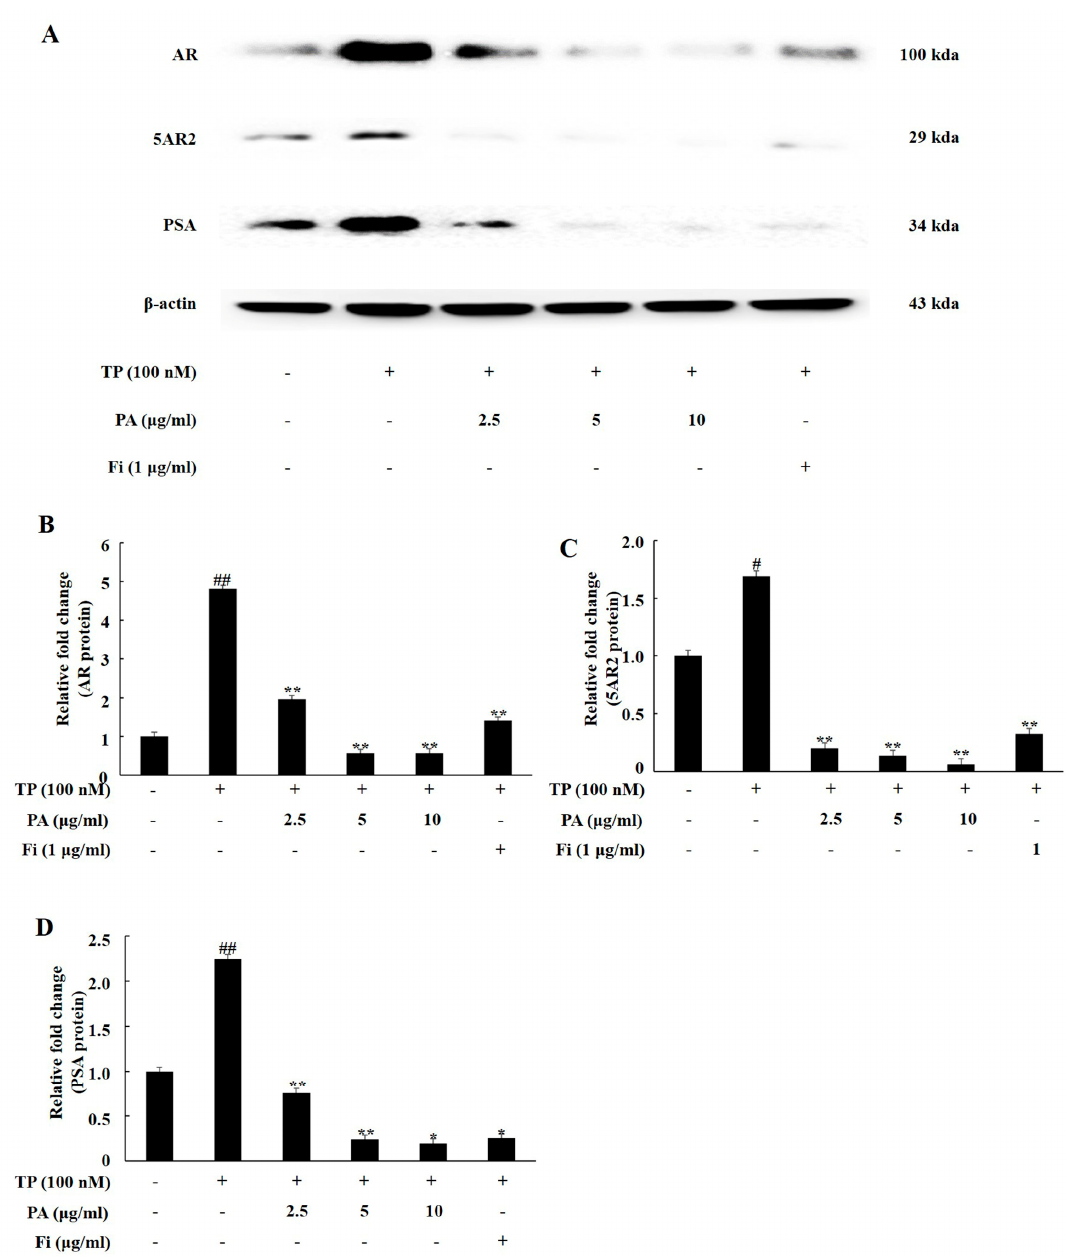
Figure 2. PA downregulated the expression of AR, 5AR2, and PSA in dihydrotestosterone (DHT)-treated LNCaP cells. Western blotting analysis for the quantification of the expression levels of the AR, 5AR2, and PSA proteins. LNCaP cells were treated in RPMI containing DHT (10 nmol), PA (2.5, 5, or 10 μ g/mL), or Fi (1 μ g/ml) for 72 h. Western blot was used to measure the protein levels of AR, 5AR2, and PSA in LNCaP cells. ( A ). The expression levels of the AR ( B ), 5AR2 ( C ), and PSA ( D ) proteins are shown; the relative protein expression levels were determined by normalization to that of β -actin. The data are expressed as the means ± SEMs. # p < 0.05 and ## p < 0.01, compared with the non-treated cells; * p < 0.05 and ** p < 0.01 compared with the TP-treated cells.